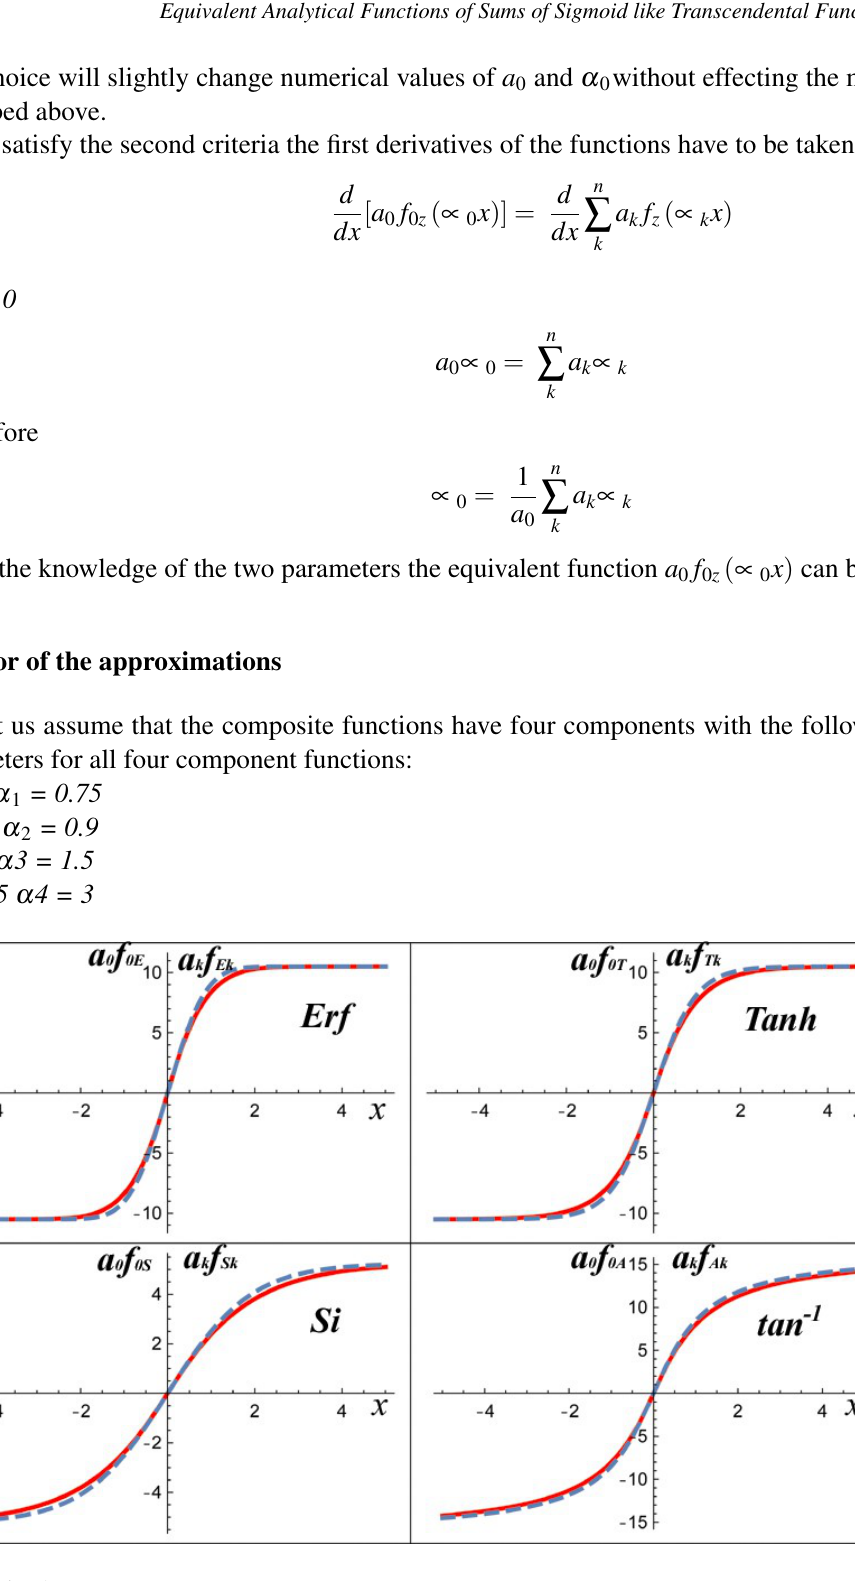
Fig. 1 The numerical and analytical sums of sigmoid functions Solid lines numerical broken lines analitical By using (8) and (11) the numerical (computer aided) values of the two parameters can be calculated as: a 0 = 10.5 and α = 1.043 0